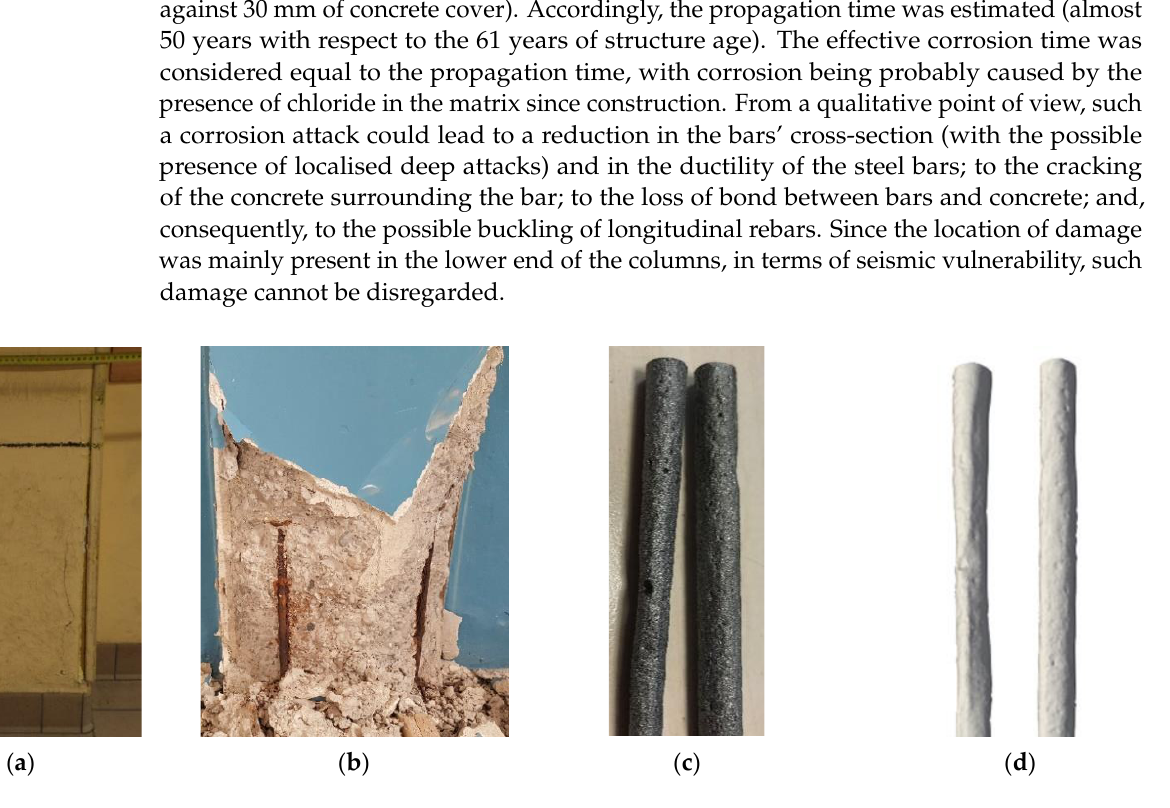
Figure 10. RC columns from the school building: longitudinal cracking ( a ); corroded bars observed after concrete cover removal ( b ); details of the extracted bars after cleaning ( c ) and by tomographic scan ( d ). (Pictures refer to different columns of the same building.)